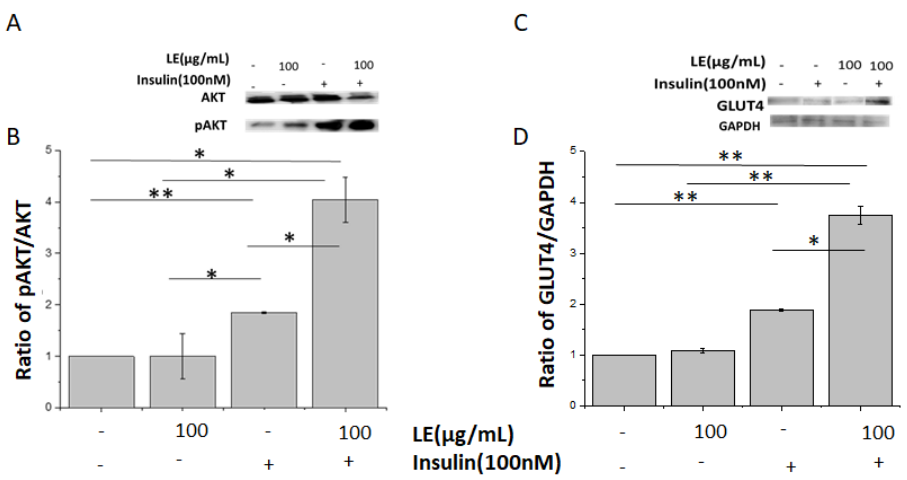
Figure 4. Lemon extract (LE) increases insulin sensitivity in di ff erentiated adipocytes. ( A ) 3T3L1 di ff erentiated adipocytes were incubated with or without LE for 10 h before being treated with 100 nM insulin for 10 min. Total AKT and phosphorylated AKT (pAKT) on Ser473 protein levels were assessed by immunoblotting in untreated differentiated cells (D), differentiated cells treated with LE (D+LE), differentiated cells treated with 100 nM insulin (D+I) and differentiated cells treated with LE